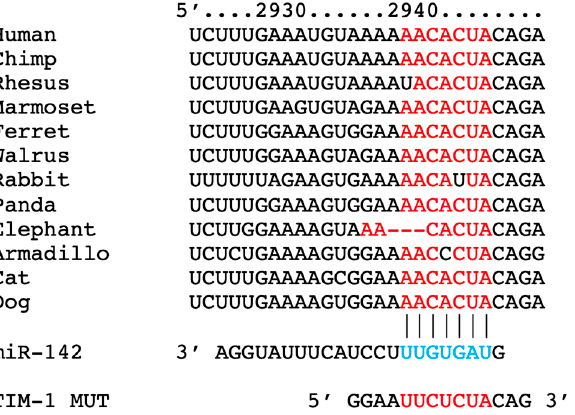
Figure 1. Identification of miR ‐ 142 as a specific modulator of TIM ‐ 1; the complementary nucleotides between the target region of TIM ‐ 1 3 ′‐ UTR and hsa ‐ miR ‐ 142 ‐ 3p are highly conserved across different species.